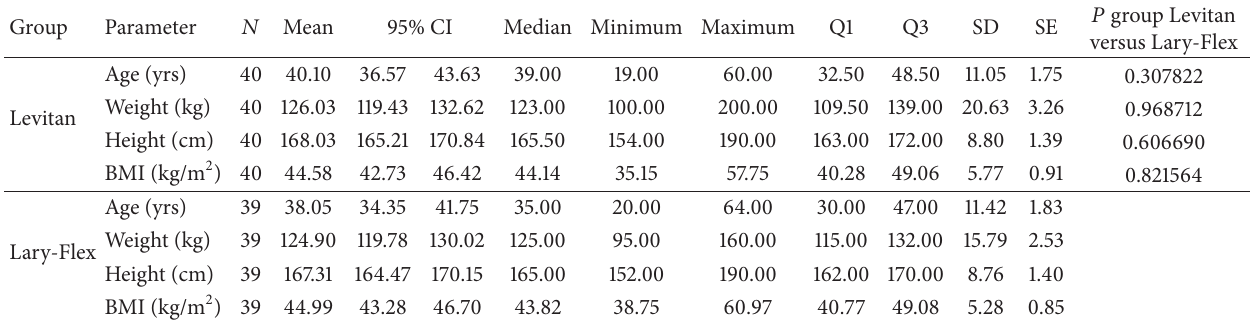
Table 2: Demographic data of studied